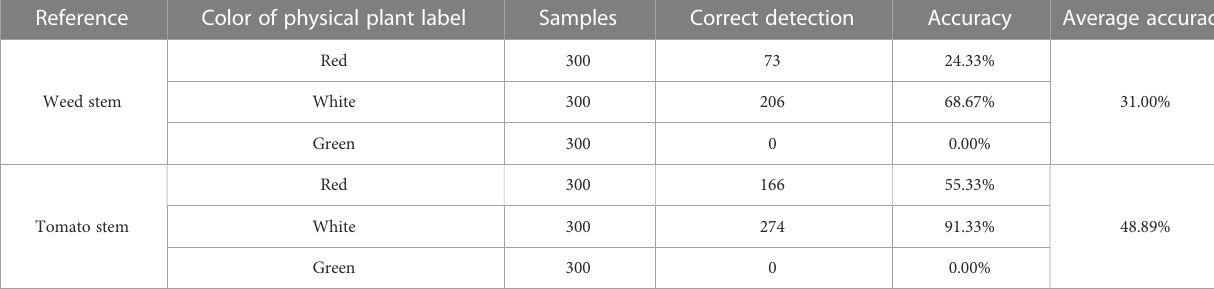
TABLE 1 The results of detecting different physical plant labels based on different